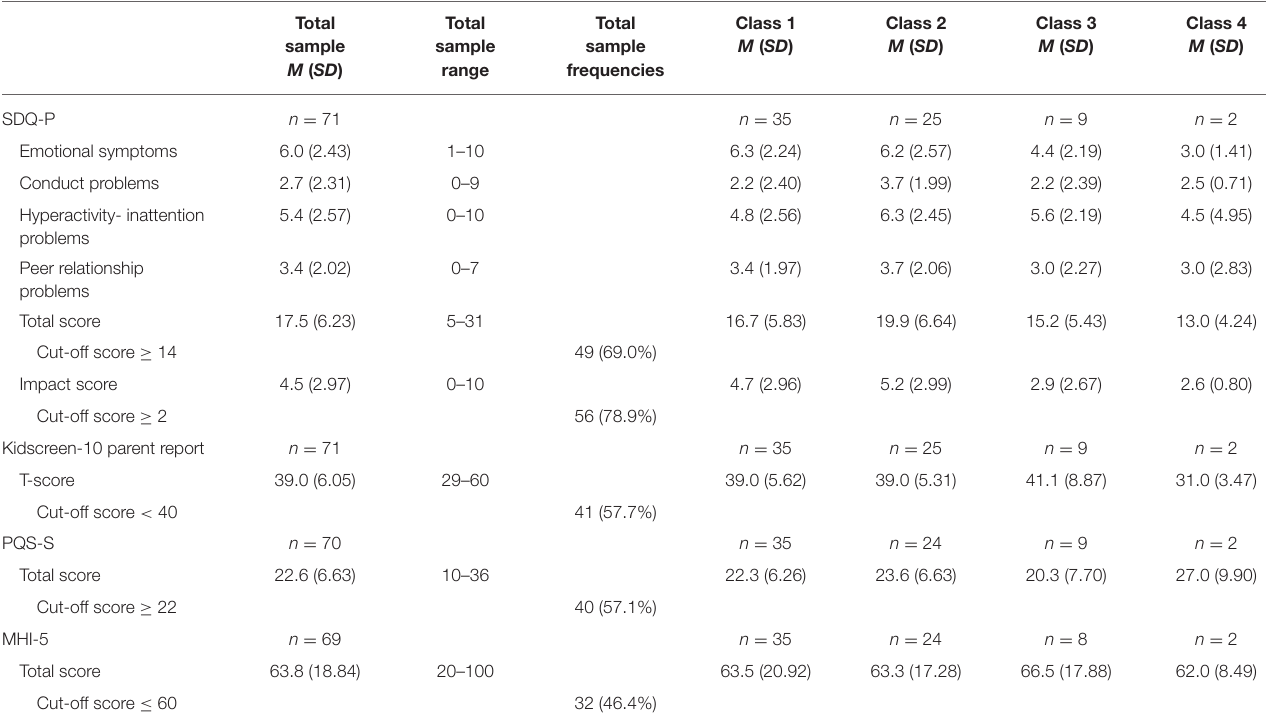
TABLE 6 | Descriptives of parent-reported